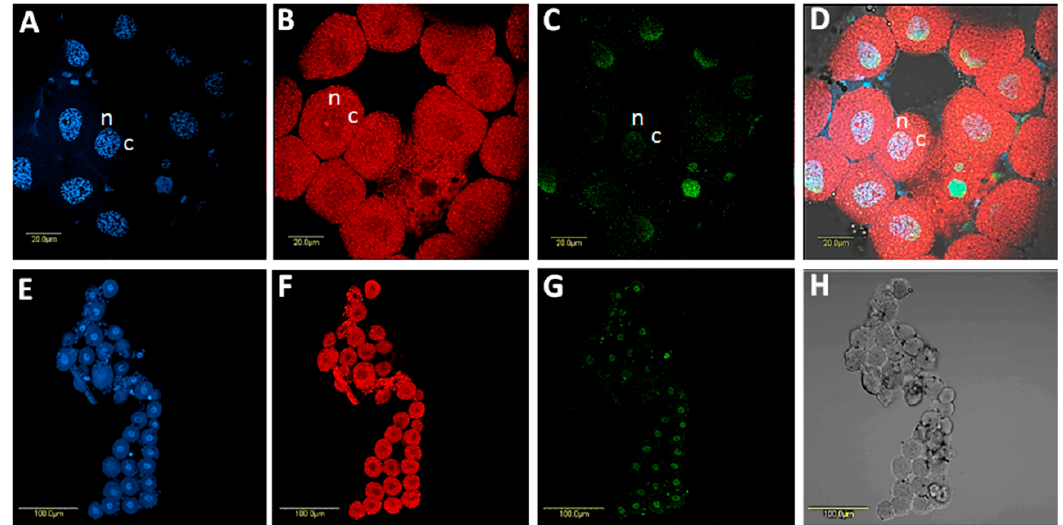
Figure 5. Localization of Sodalis in B. trigonica bacteriocytes using FISH with Sodalis- specific probe. A , DAPI-stained bacteriocyte nuclei. B , Same photo as in A showing the localization of Carsonella, the primary symbiont of psyllids (red) in the bacteriocytes. C , Sodalis localization (green) inside bacteriocyte nuclei. D , Overlay of A, B and C under a bright field. E-G show a cluster of bacteriocytes with DAPI, Carsonella and Sodalis staining, respectively. H shows the same cluster of bacteriocytes under a bright field. n: nucleus; c: cell cytoplasm.